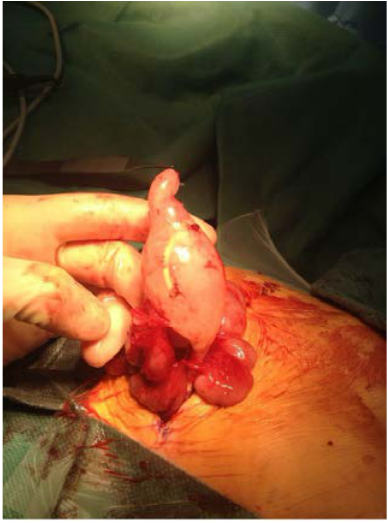
Figure 1. Infected pseudocyst in a patient with VPS and acute appendicitis.